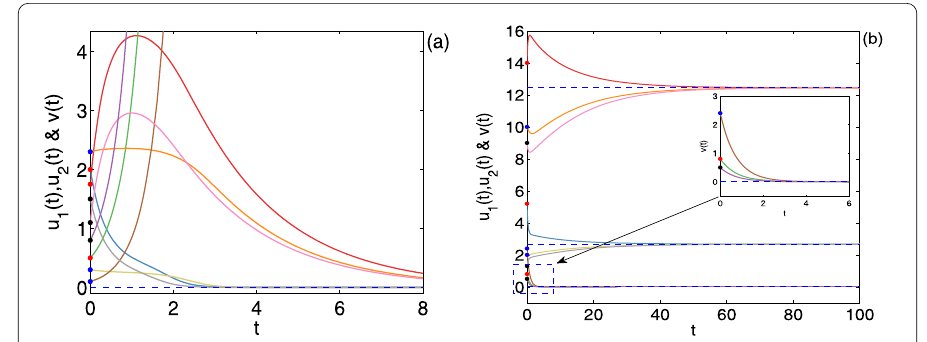
Figure 2 Time series of u 1 ( t ), u 2 ( t ) and v ( t ) generated by the model (1.5): ( a ) Three initial values are chosen as ( u 1 (0), u 2 (0), v (0)) = (1.75,2,0.5),(2.3,0.3,0.1),(1.1,1.5,0.8) marked red points, blue points and black points, respectively. The dashed line stands for u 2 ( t ) = 0. ( b ) Three initial values are chosen as ( u 1 (0), u 2 (0), v (0)) = (14,5.2,0.8),(10,2,2.4),(9,1.3,0.5) marked red points, blue points and black points, respectively. The dashed line stands for u 1 ( t ) = 12.444444444446397, u 2 ( t ) = 2.666666666667100 and v ( t ) = 0, respectively